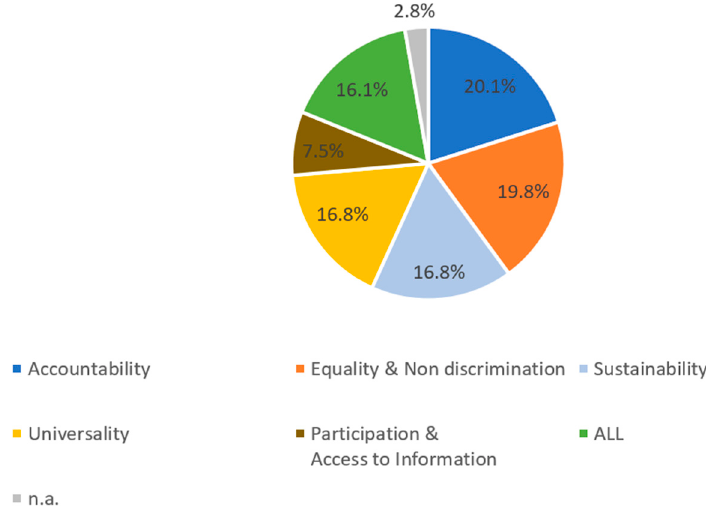
Figure 1. Distribution of recommendations by principle of the human rights.